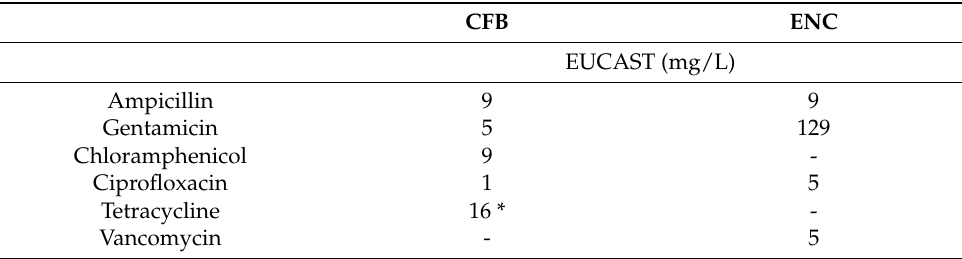
Table 2. Concentrations of applied antibiotics according to EUCAST and CLSI